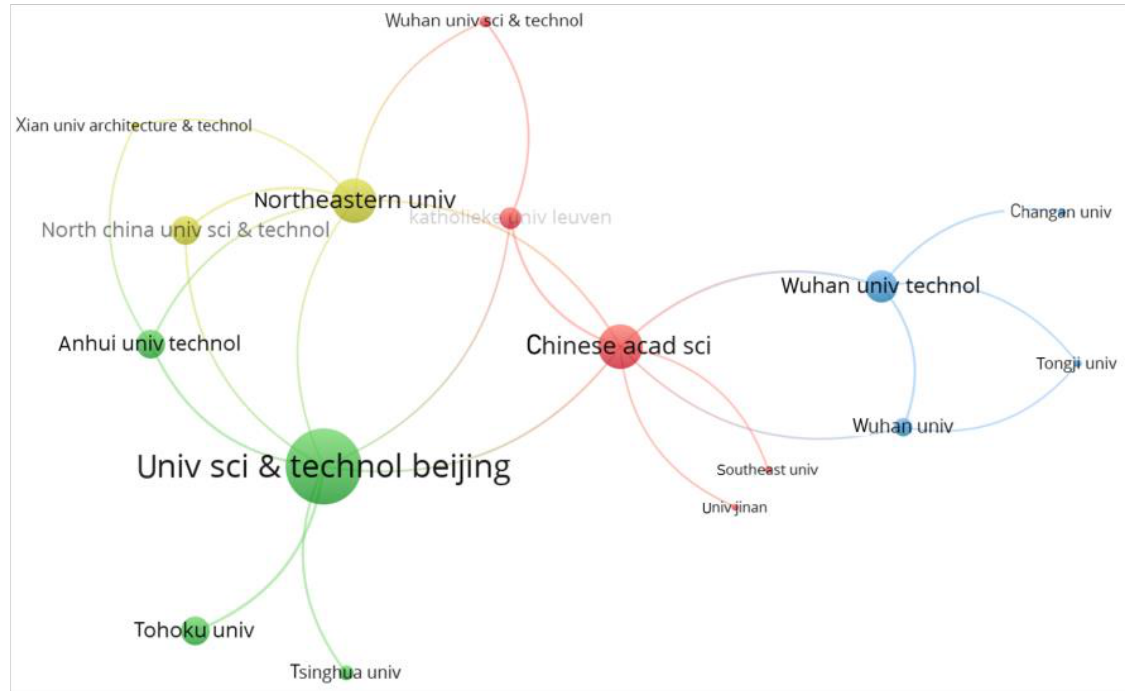
Figure 7. Cooperation network among institutions in the research field of steel slag. To more intuitively characterize the contribution of each institution in the coopera- tion network, the density maps based on the total link strength are drawn, as shown in Figure 8. The larger the number of total link strengths for an institution, the closer the color of the institution is to red. It was found from Figure 8 that University of Science Technology Beijing ranked first in terms of the total link strength, with a value of 33, followed by Chinese Academy of Sciences, Northeastern University China, and Wuhan University of Technology. The co-authoring publication is an effective tool to develop an inventive research direction and facilitate academic exchange. Close cooperation can give full play to the advantages and characteristics of various institutions, such as huge databases, complete experimental platforms, or abundant theoretical basis, thus promoting in-depth exploration of more valuable and meaningful issues and research. Consequently, the cooperative work among authors from different countries and institutions are encour- aged to expand. These bibliometric analyses of institutions can guide scholars to execute the following academic steps, such as choosing future work institutions or looking for research